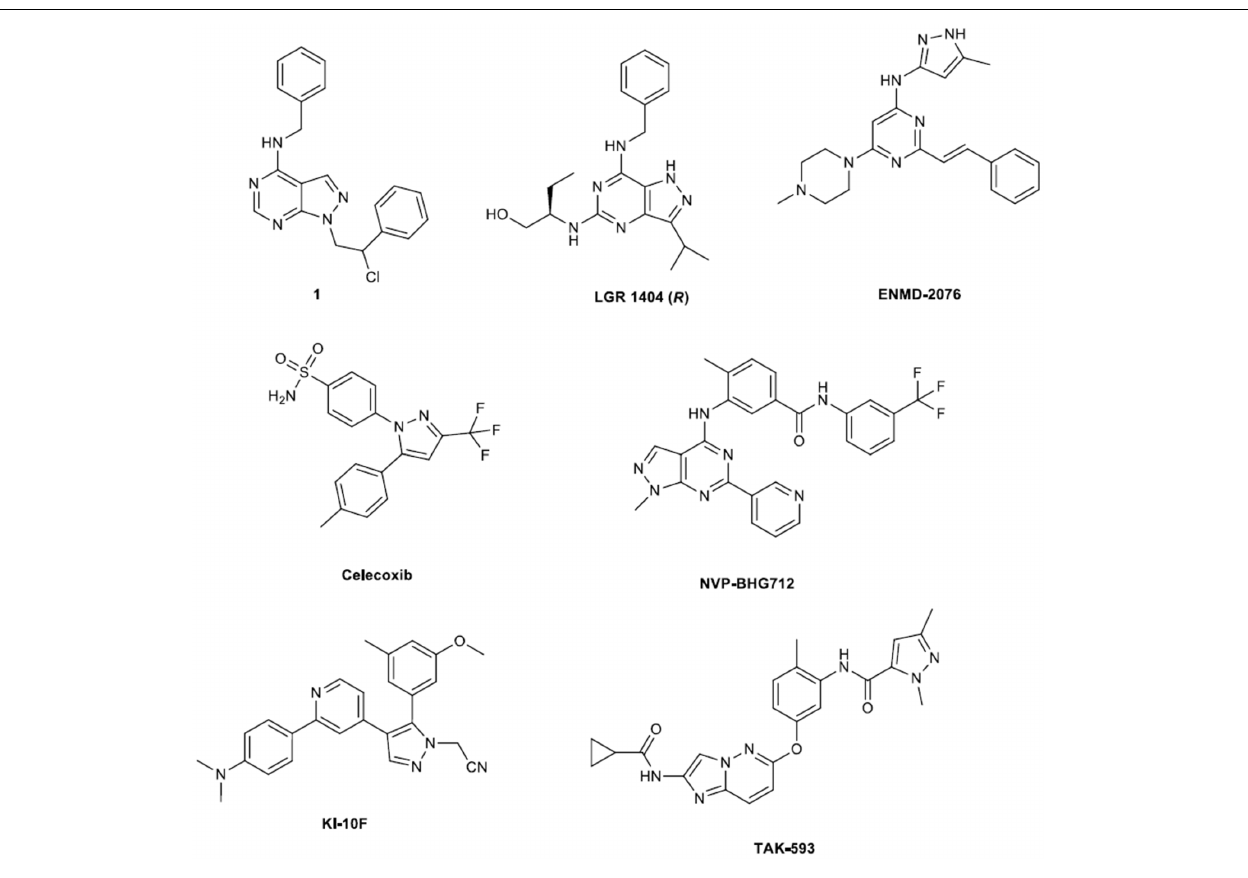
FIGURE 1 | Key structures of active anti-angiogenic